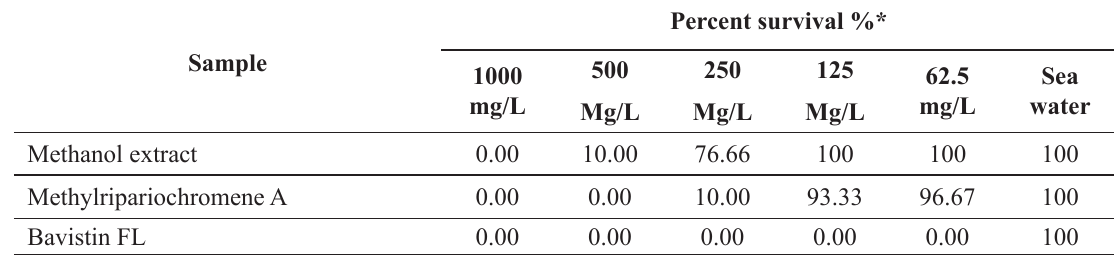
Table 3: Percent survival of brine shrimps against the methanol extract of A. riparia and isolated methylripariochromene